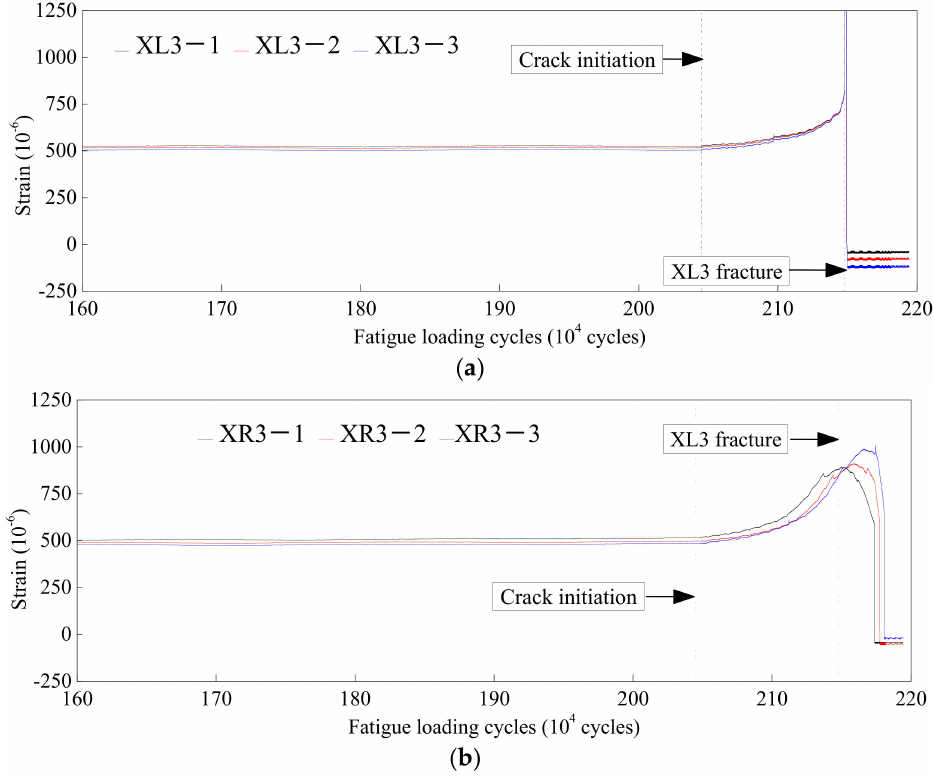
Figure 12. Time histories of strain: ( a ) XL3; and ( b ) XR3. When the number of reversed loading cycles reached 2,045,000, both strain at XL3 and displacement at WL2 gradually started increasing with increase in the reversed loading cycles. By combining the observation with the phased array nondestructive detection, as shown in Figure 13, where C L and h L represent the length and the depth of the fatigue crack in the left side of the section, C R and h R represent the length and the depth of the fatigue crack in the right side of the section, and the red line represents the fatigue crack, it can be concluded that the girder started cracking at XL3, with the length, width and depth of fatigue crack being 0.8 mm, 0.1 mm, and 0.1 mm, respectively. The fatigue life consumed before fatigue crack initiation accounted for 93.0% of the total reversed fatigue loading cycles. Compared to that of the composite girder with CSW-ST truss chords reported in [11], concrete in the chord lengthened the service life of the composite girder with CSW-ST truss chords by about 61.5% under the action of the same fatigue load.